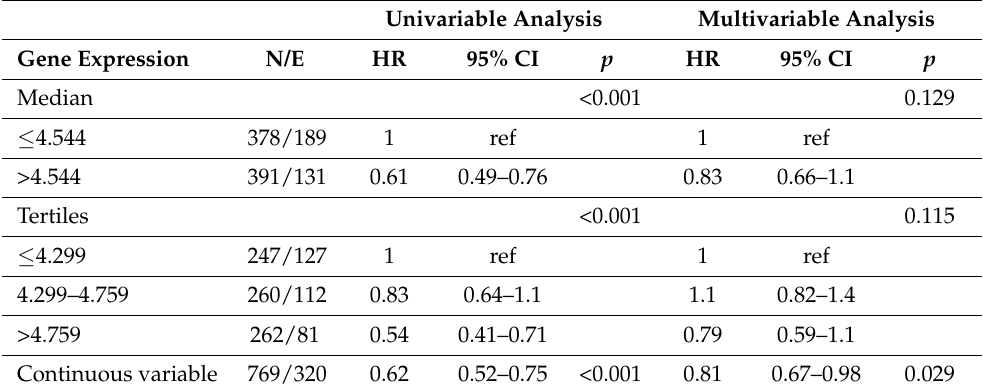
Table 3. Event Free Survival of 769 NB patients in relation to RNF144A expression levels evaluated by the Cox model.